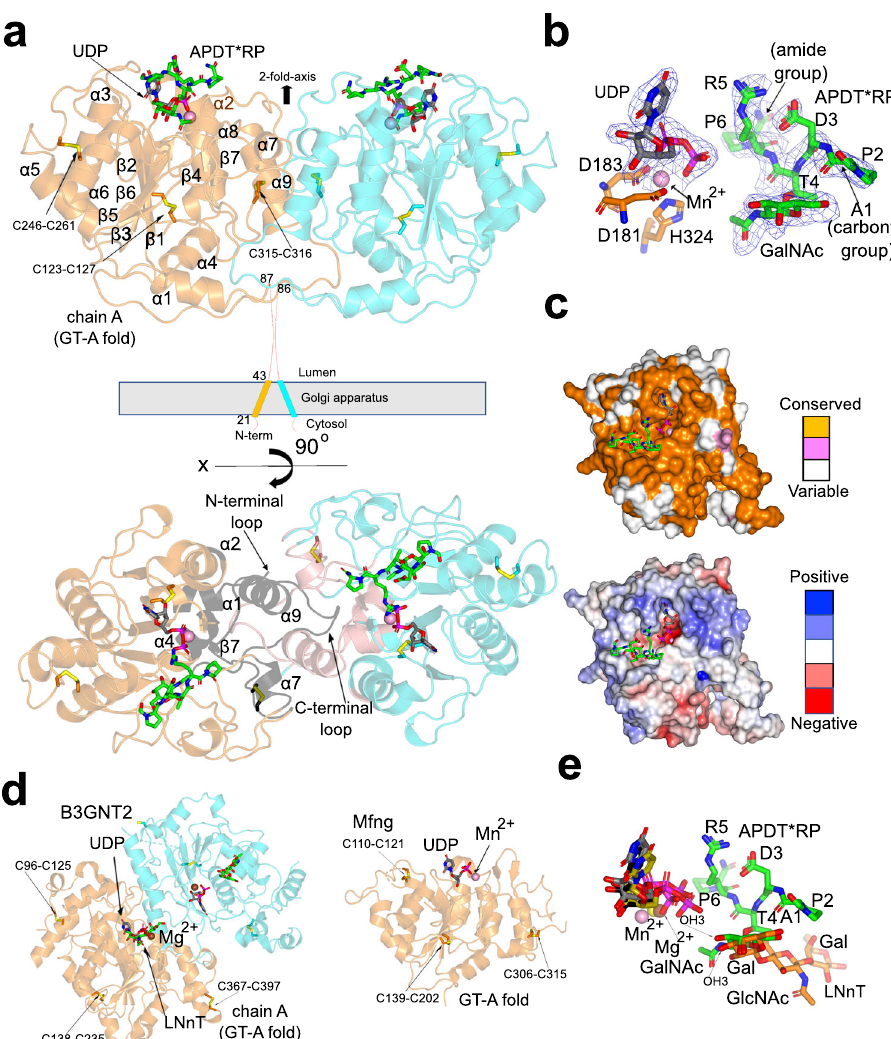
Fig. 3 Crystal structure of Dm C1GalT1 S73-Q388 in a ternary complex with UDP-Mn 2 + -APDT*RP. a Ribbon structure of the dimeric form of Dm C1GalT1 complexed to UDP-Mn 2 + and APDTR*P (upper panel). Chain A and B of Dm C1GalT1 are colored in orange and cyan, respectively. The UDP nucleotide is depicted with gray carbon atoms whereas the manganese atom is shown as a pink sphere. The glycopeptide is shown as green carbon atoms. Disul fi de bridges are indicated as yellow sulfur atoms. Each monomer contains three conserved disul fi de bridges, with the latest being formed by two contiguous Cys residues (see also Supplementary Fig. 1). In the lower panel, the dimeric form is displayed in a different view highlighting the secondary structures and the N- and C-terminal loops regions engaged in interactions in the interface (black and pink for chain A and B, respectively). In ( b ) Close-up view of the active site showing the bound Mn 2 + , UDP and ADPT*RP. Electron density maps are Fo – Fc (blue) contoured at 2.2 σ for APDT*RP and UDP. Except for the fi rst N-terminal residue (Ala1) of APDT*RP, the density for the glycopeptide and UDP was well de fi ned. Note that the Pro6 fi nishes as an amide group. c (upper panel) Surface representation of Dm C1GalT1, color-coded by degree of sequence conservation. (lower panel) Electrostatic surface representation of Dm C1GalT1 (scale bar ranged from − 5 kTe − 1 to + 5 kTe − 1 ). d Structural homologues of Dm C1GalT1. Ligands and cofactors follow the same colors as indicated above. e Superposition of the ligands of Dm C1GalT1, B3GNT2 and Mfng. LNnT and the glycopeptide are depicted as orange and green carbon atoms, respectively. UDP carbon atoms are colored as gray in Dm C1GalT1, olive in B3GNT2 and black in Mfng. Mn 2 + is shown as a pink and yellow sphere in Dm C1GalT1 and Mfng, respectively. Mg 2 + is shown as a yellow